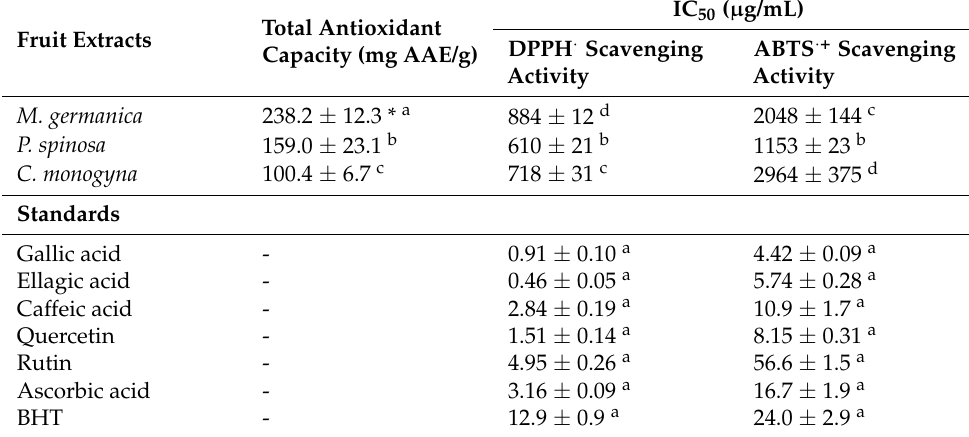
Table 3. Antioxidant activity of M. germanica , P. spinosa and C. monogyna fruit ethanolic extracts and standard